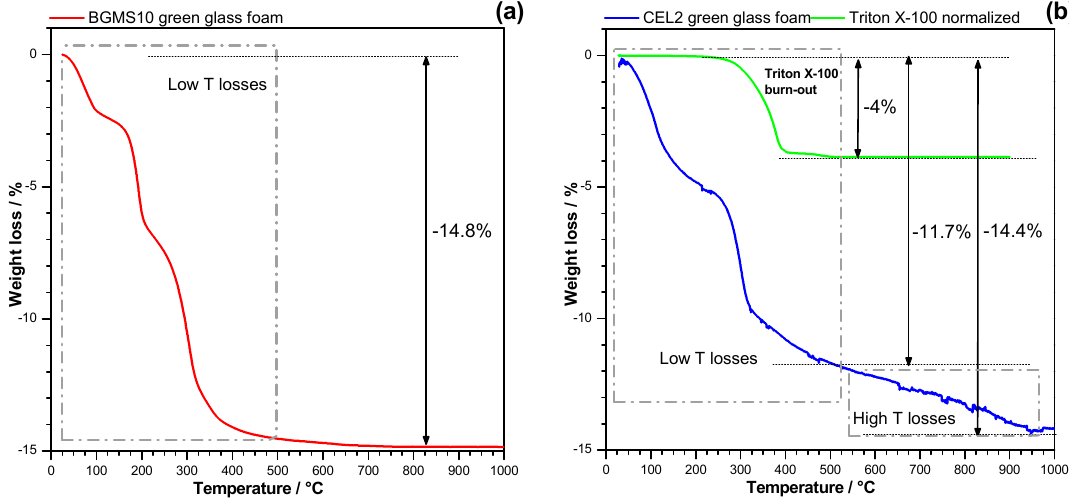
Figure 7. Comparison between BGMS10 glass activated with TMAH ( a ) and CEL2 glass activated with NaOH ( b , adapted from Elsayed et al. [30]).